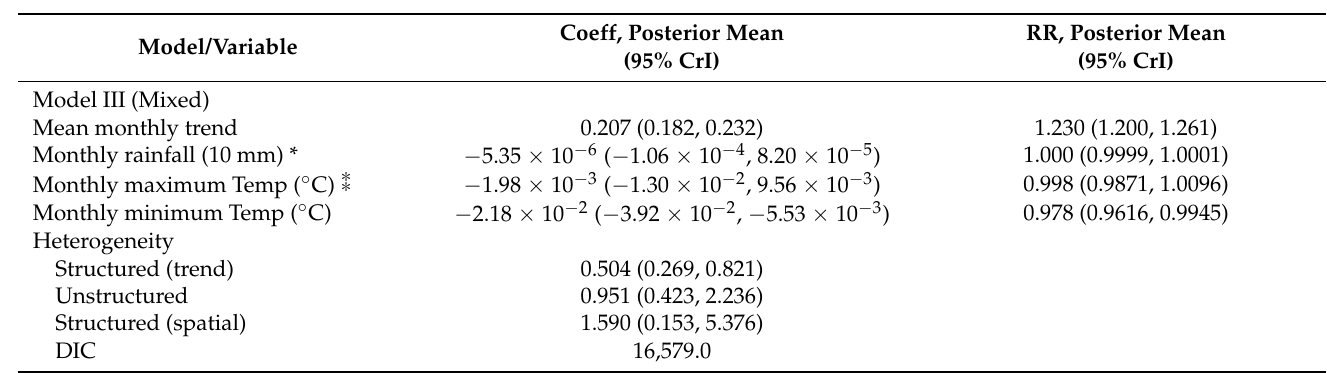
Figure 4. Spatial negative binomial regression analysis. ( a ) Unstructured random effects of malaria in Model I; ( b ) Trend analysis during the study period, 2015–2019. Source: Authors’ own contributions.